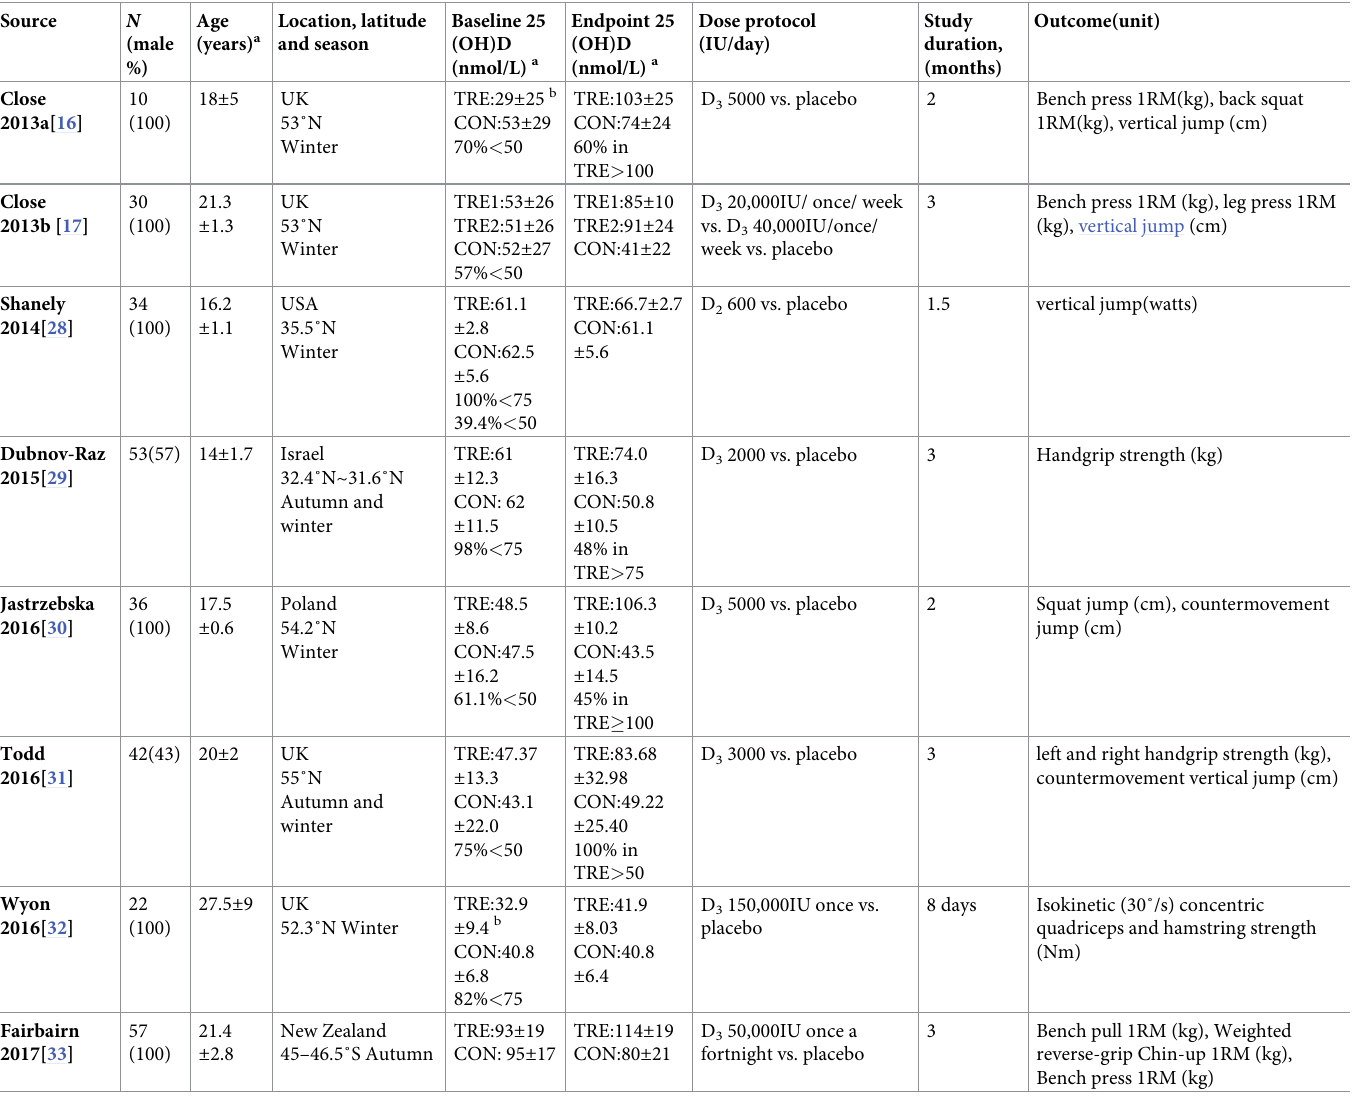
a Values are presented as mean ± standard deviation (SD), range, median or unless otherwise specified. b Treatment group significantly lower than control group ( p <